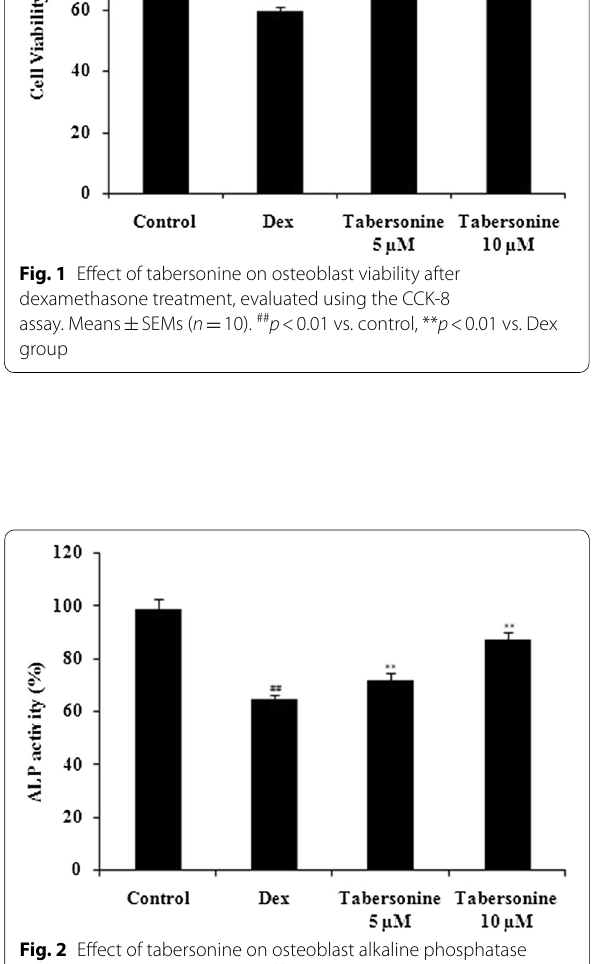
SEMs ( n 10). ## p < 0.01 vs. control, ** p < 0.01 vs. Dex ± =